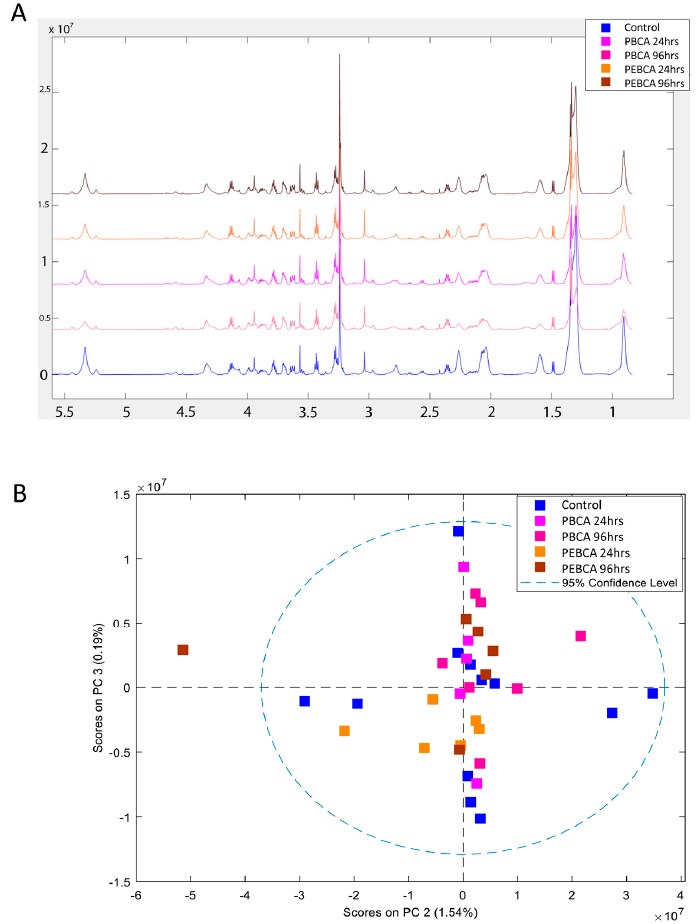
Figure 5. High-resolution magic angle spinning magnetic resonance (HR MAS MR) spectroscopy of tumor tissue. The metabolic fingerprints of tumor tissue from untreated controls and tumor tissue exposed to PEBCA and PBCA were highly similar ( A ). The PCA analysis did not indicate any significant differences between the treatment groups ( B ). PBCA: poly(butyl cyanoacrylate), PEBCA: poly(2-ethyl-butyl cyanoacrylate).